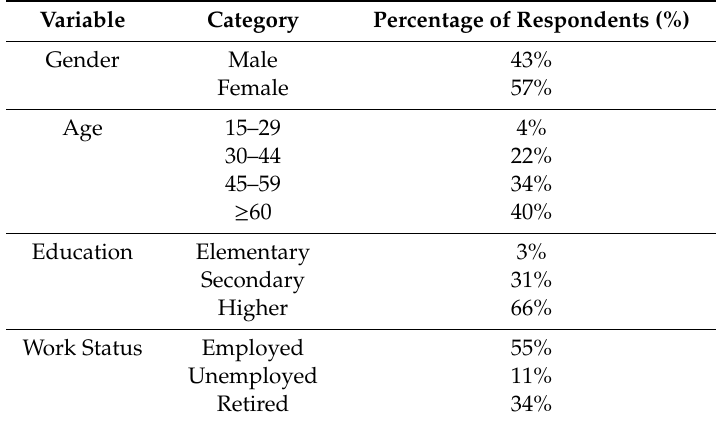
Table 2. Sociodemographic information on focus group participants ( n =